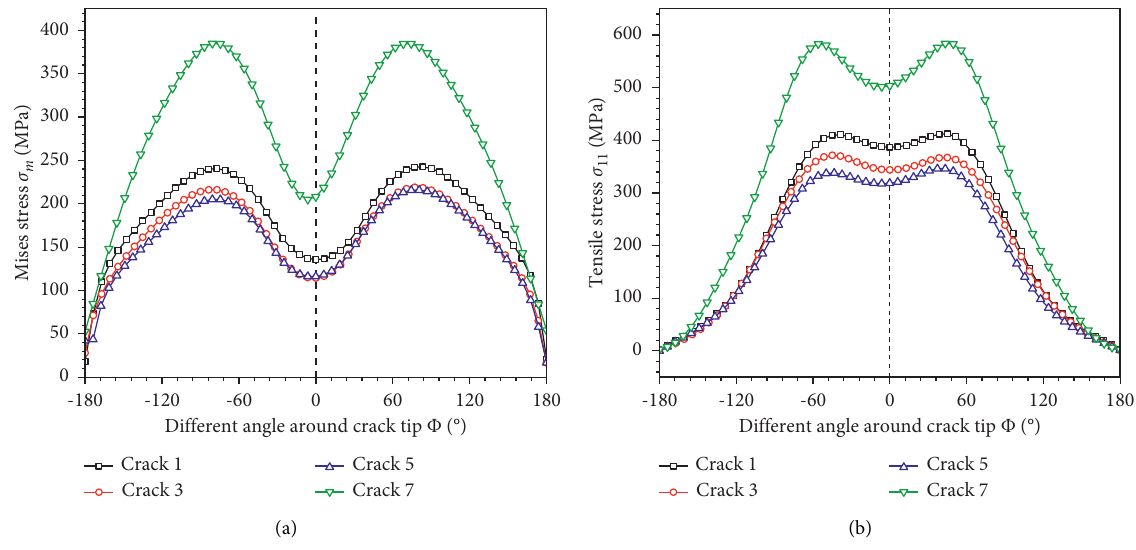
Figure 7: The stress curve at the crack tip of the noninterface. (a) Mises stress and (b) tensile stress.